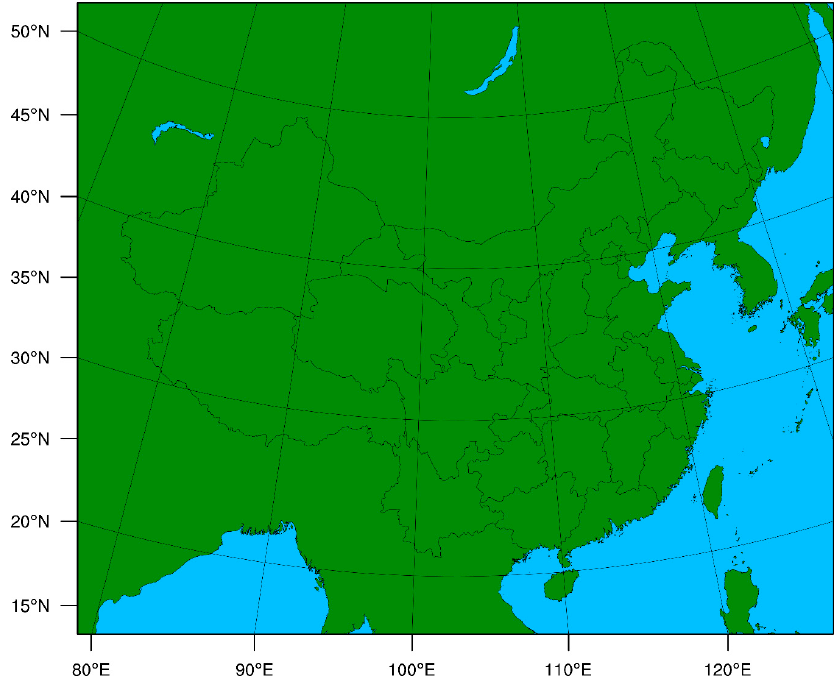
Figure 3. Domain used in predictions.